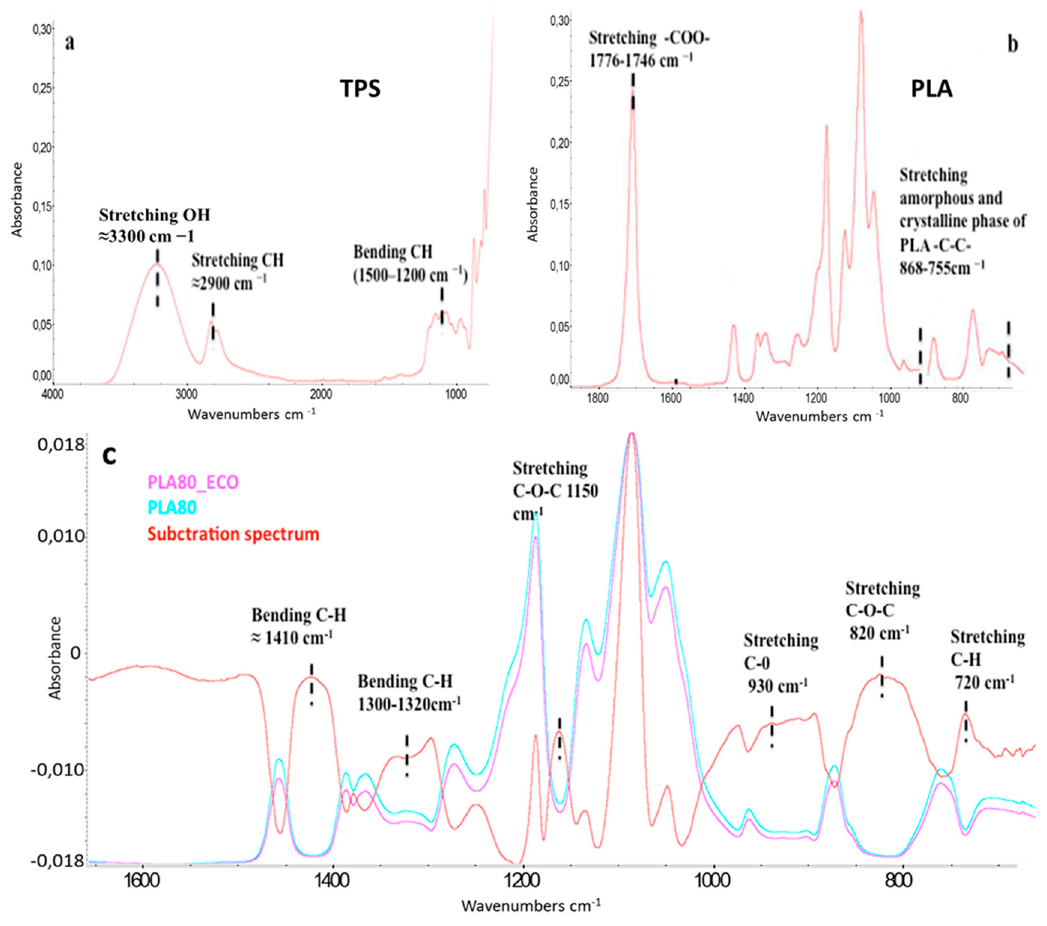
Figure 1. FTIR-ATR of ( a ) neat thermoplastic starch (TPS), ( b ) neat poly (lactic acid) (PLA) (a,b main absorption peaks), ( c ) carbonyl and fingerprint regions of PLA80_ECO (pink curve), PLA80 (azure curve), and their spectral subtraction (red curve) in a magnified absorbance scale.